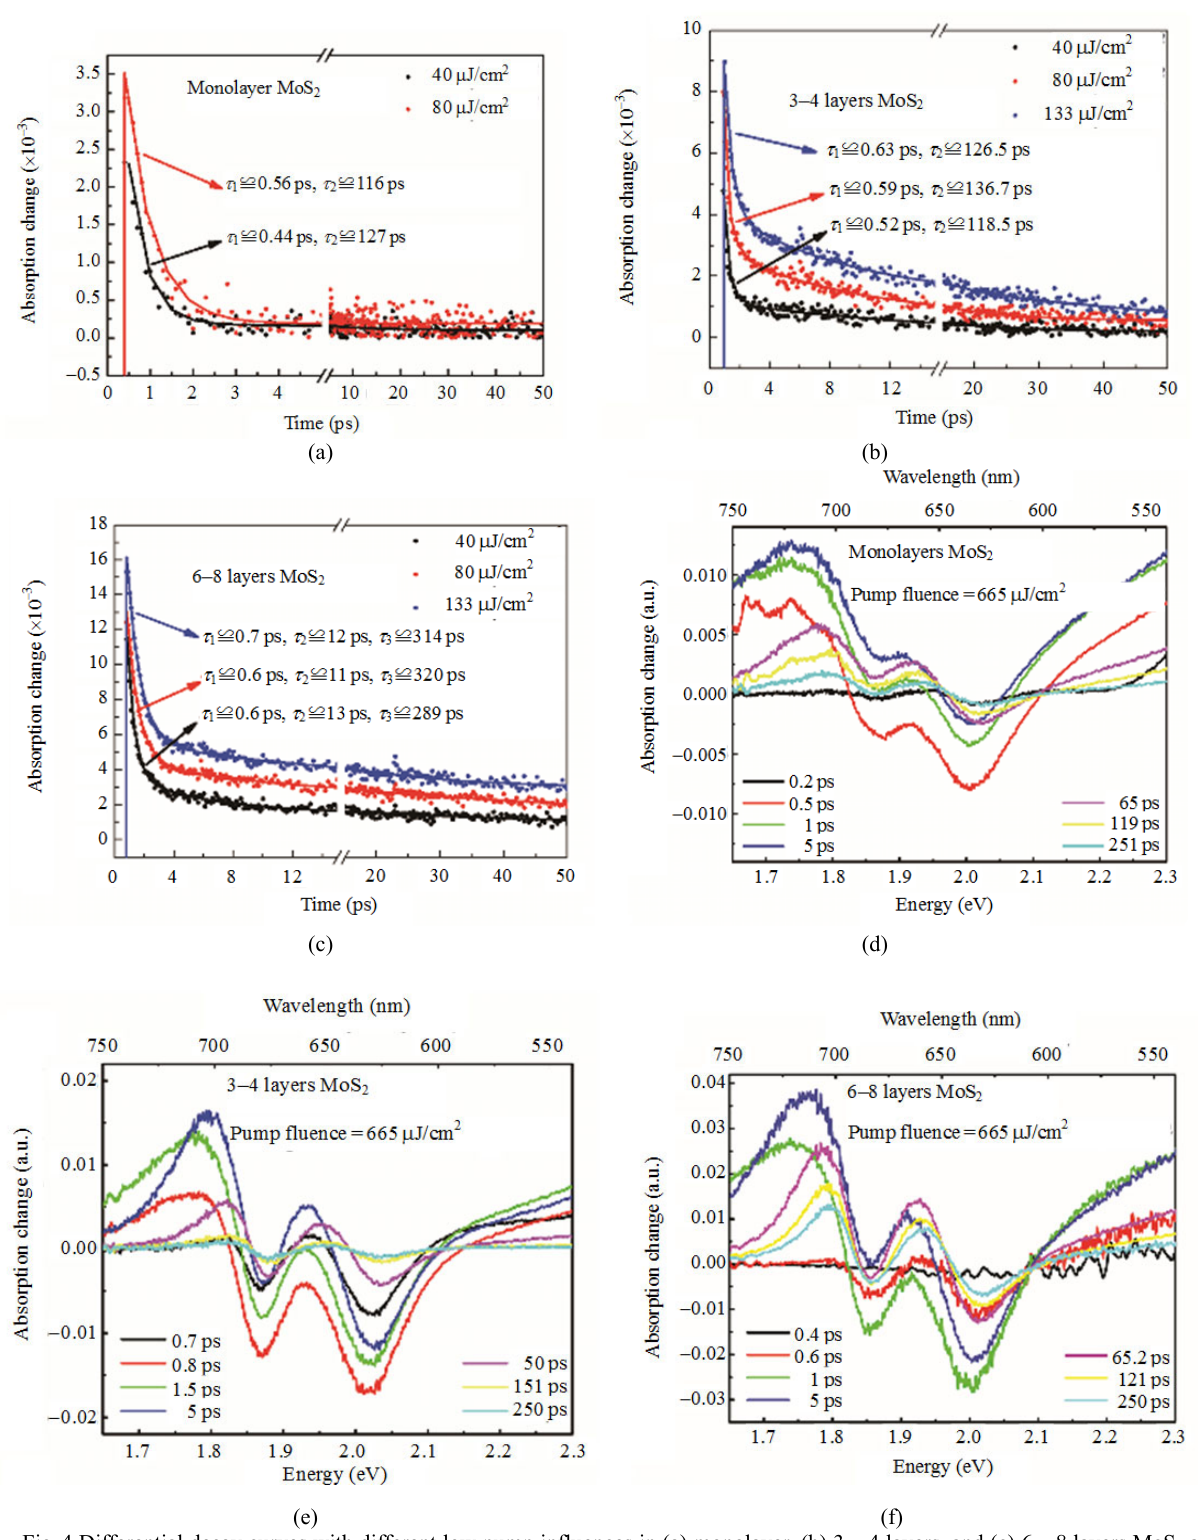
Fig. 4 Differential decay curves with different low pump influences in (a) monolayer, (b) 3 ‒ 4 layers, and (c) 6 ‒ 8 layers MoS 2 as functions of delay time. The dots are experimental data and, the solid lines show theoretical fit. Transient absorption spectra calculated for different values of time delay with the pump fluence of 665 μ J/cm 2 , in cases of three films: (d) monolayer, (e) 3 ‒ 4 layers, and (f) 6 ‒ 8 layers MoS 2 . In these cases, the pump photon energy is 3.1 eV, and the supercontinum white light is used as the